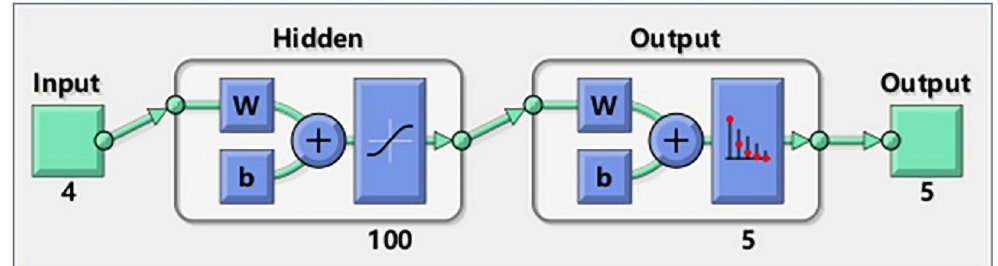
Fig 19. Neural network model of tractor driving vibration